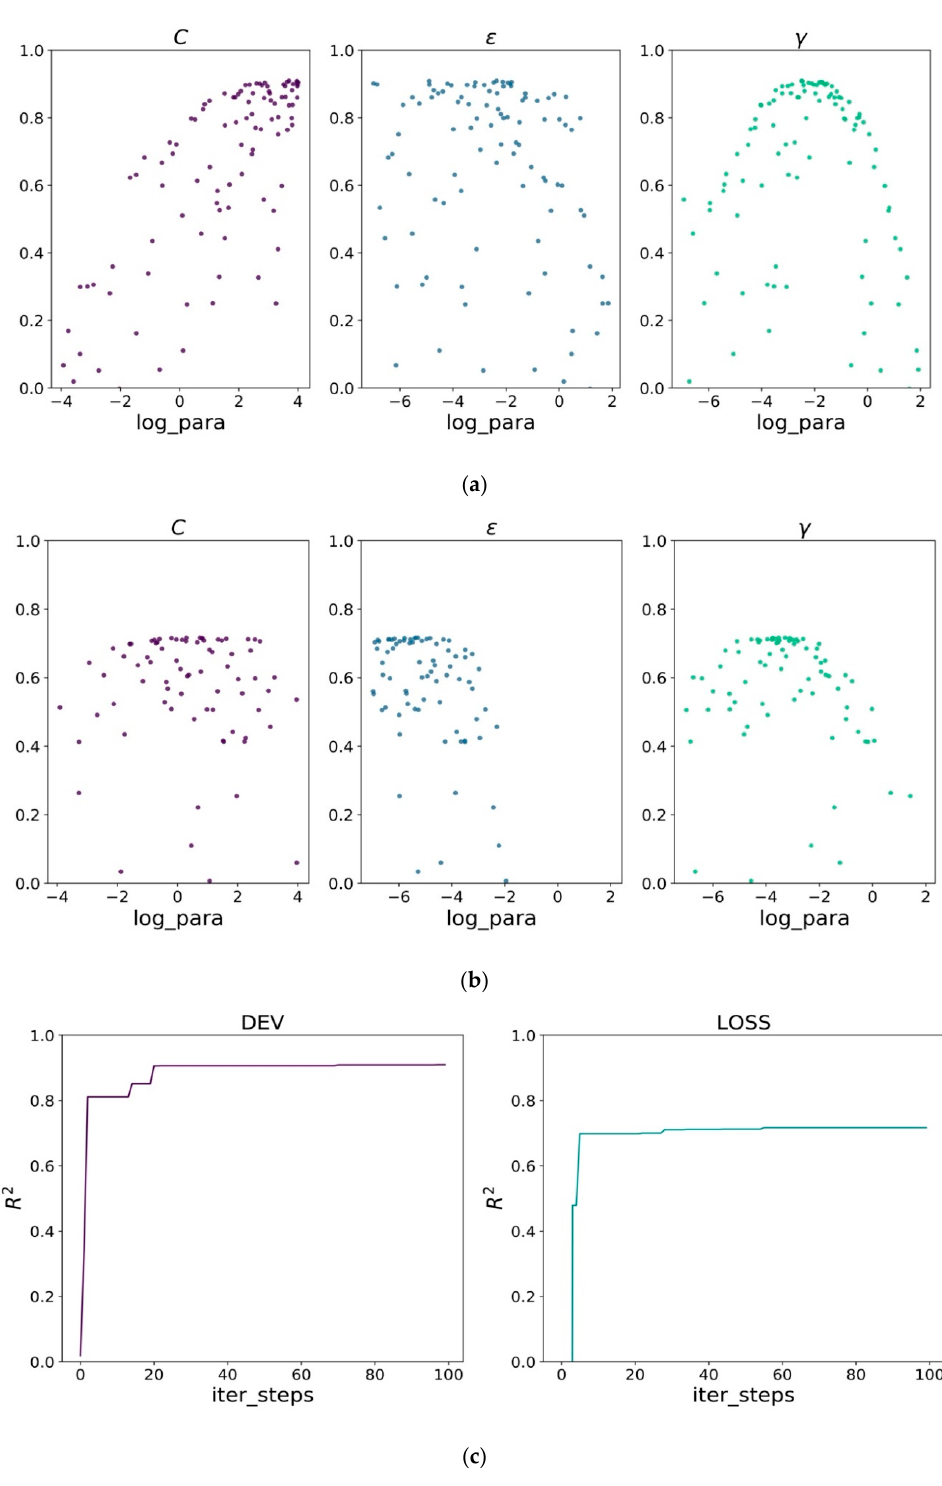
Figure 7. Optimization of training SVR models: ( a ) Hyper parameters search of deviation angle model; ( b ) Hyper parameters search of total pressure loss; ( c ) Optimization curve of models.